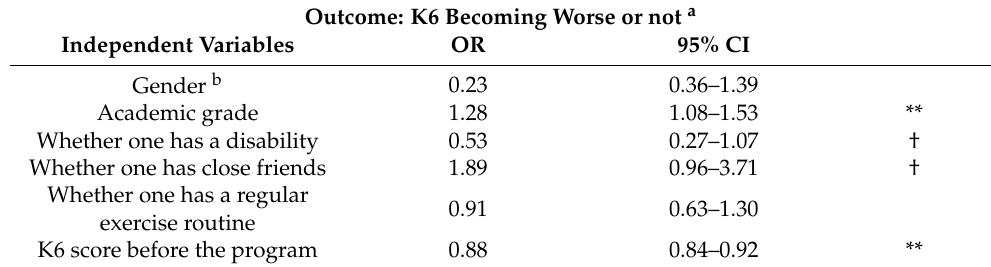
Table 4. Logistic regression analysis on K6 score becoming worse or not (n =